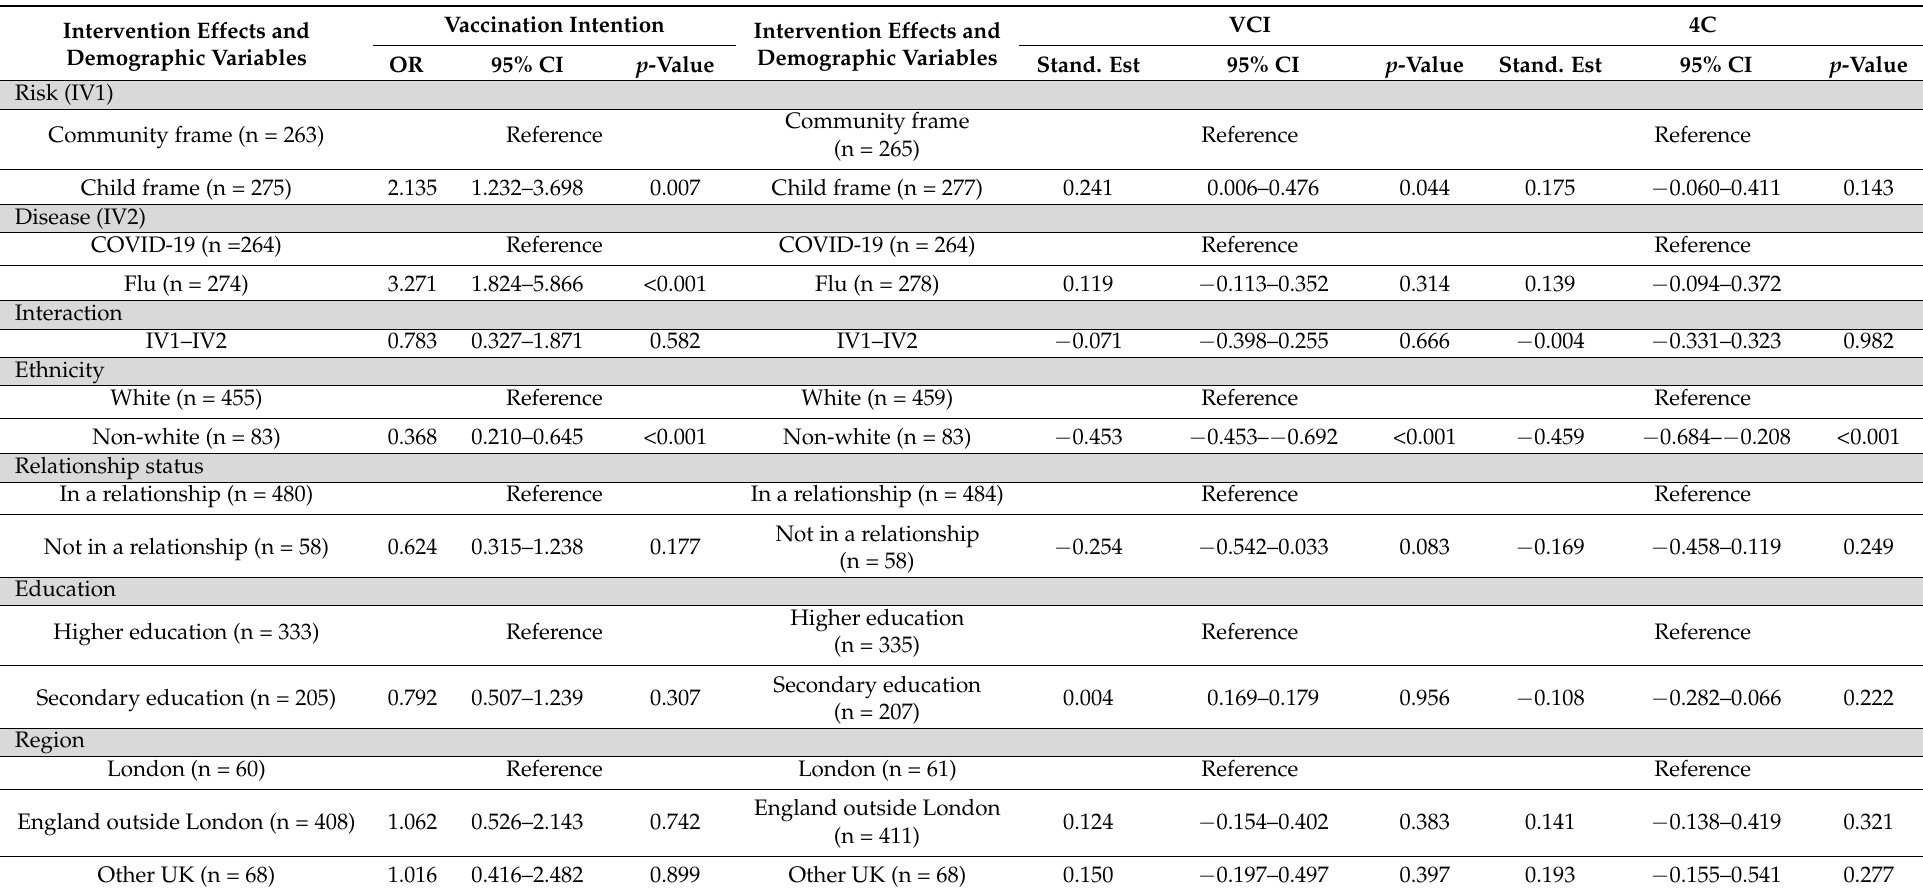
Table 2. Logistic of disease type and risk frame on (i) vaccination intention (n = 538) and multinomial linear regression of demographics on (ii) Vaccine